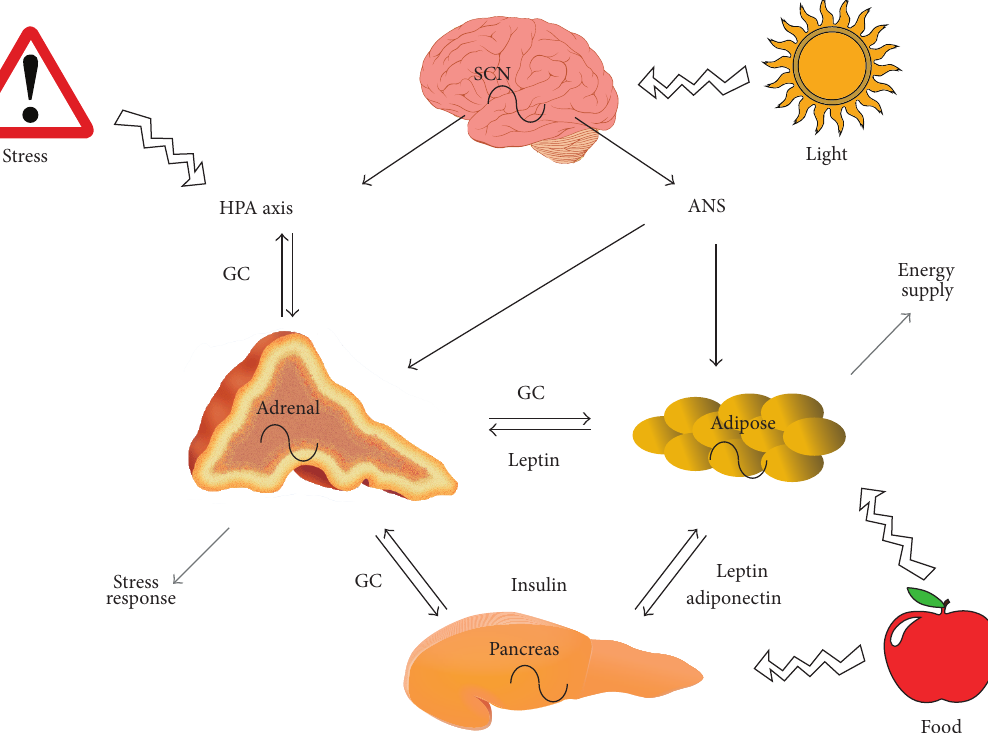
Figure 1: Interaction of stress axis and adipose circadian rhythms. Rhythmic adrenal glucocorticoid (GC) release negatively feeds back on the HPA axis and stimulates lipid mobilization in adipose tissue and release of insulin from the pancreas. Insulin supports lipogenesis in adipocytes, while the adipokine leptin inhibits insulin secretion from the pancreas and glucocorticoid release from the adrenal. Adiponectin increases insulin sensitivity in cells. External factors like stress and food intake affect the peripheral rhythms, while light exposure entrains the system via the SCN. For more details see text (autonomic nervous system